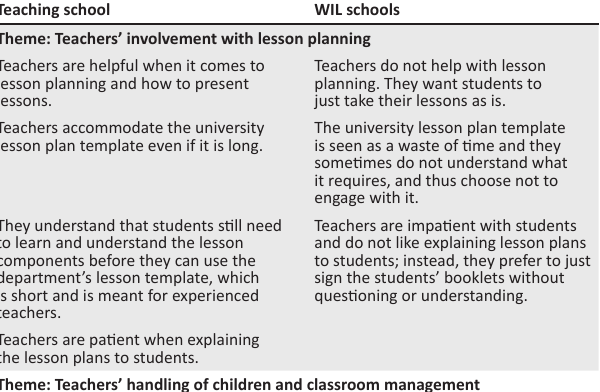
TABLE 3: Comparison between student teachers’ views on their practice learning experiences at the teaching school and work integrated learning schools. Teaching school WIL schools Theme: Teachers’ involvement with lesson